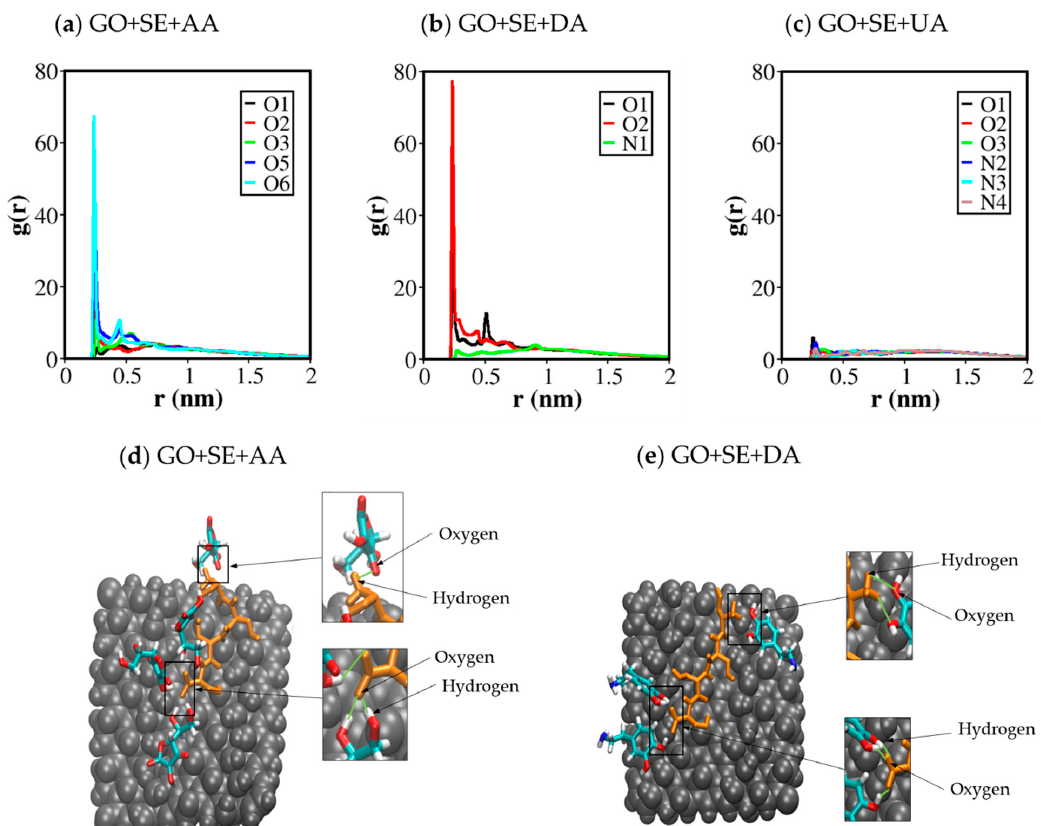
Figure 6. Radial distribution function (RDF) of each hydrogen bond donor atom with ( a ) AA; ( b ) DA; and ( c ) UA around the group of acceptor atoms within tetraserines; ( d , e ) a conformational snapshot taken after 100 ns showing hydrogen bonds formed by ( d ) AA and ( e ) DA on the tetraserine.